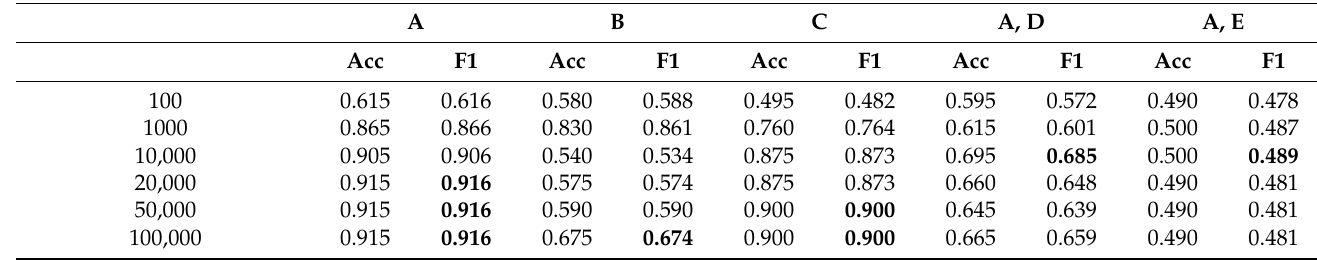
Table A4. TF-IDF